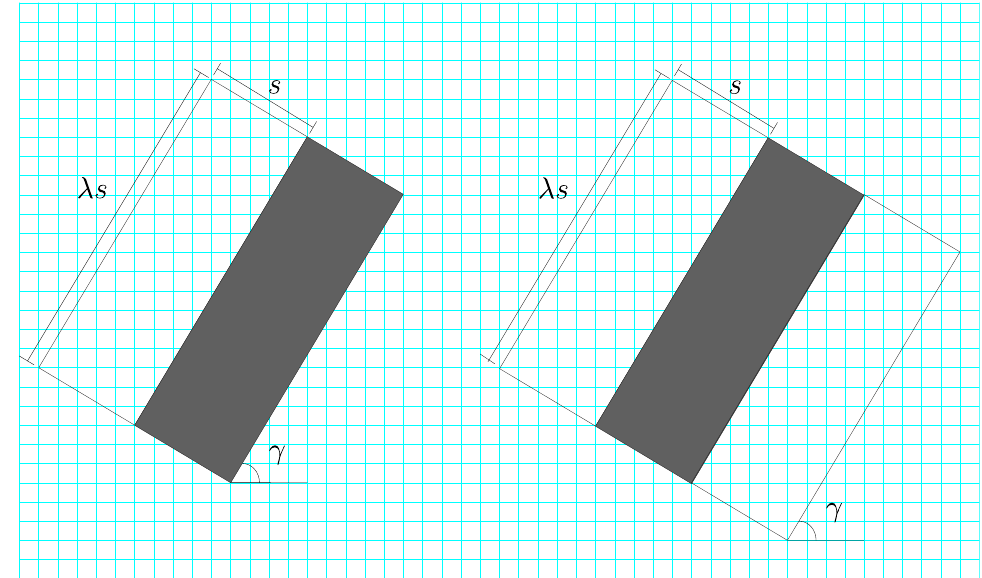
Figure 9. Illustration of shape of DoB kernels that are controlled by three parameters ( left : 1 order DoB filter, right : 2 order DoB